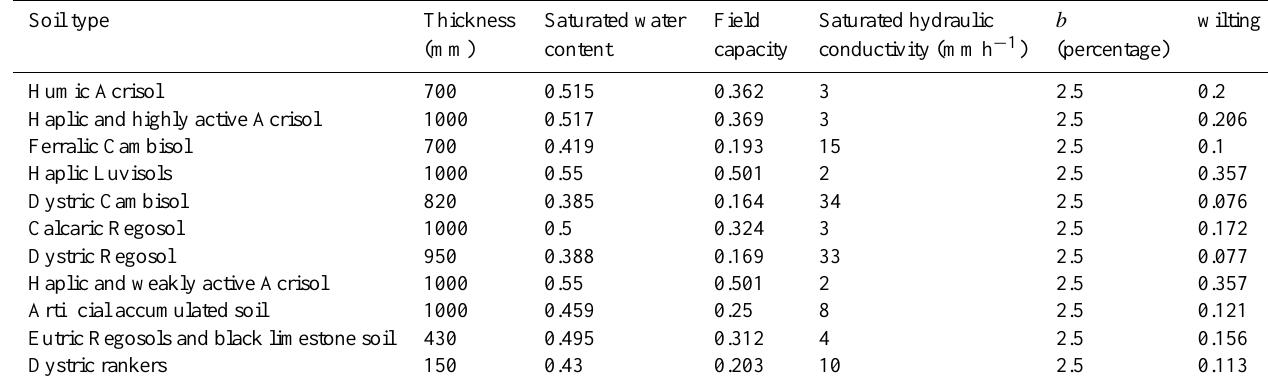
Table 4. Initial values of soil-based parameters in UMWC.